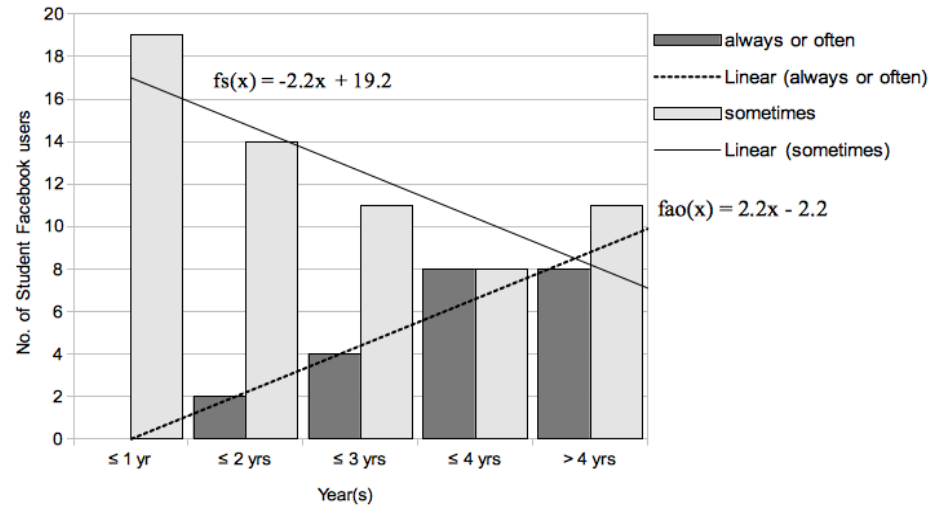
Figure 15. Correlation between duration on Facebook and numbers of students who sometimes , and always or often searched on Facebook. Note: fs(x) refers to the regression line for sometimes and fao(x) refers to the one for always or often